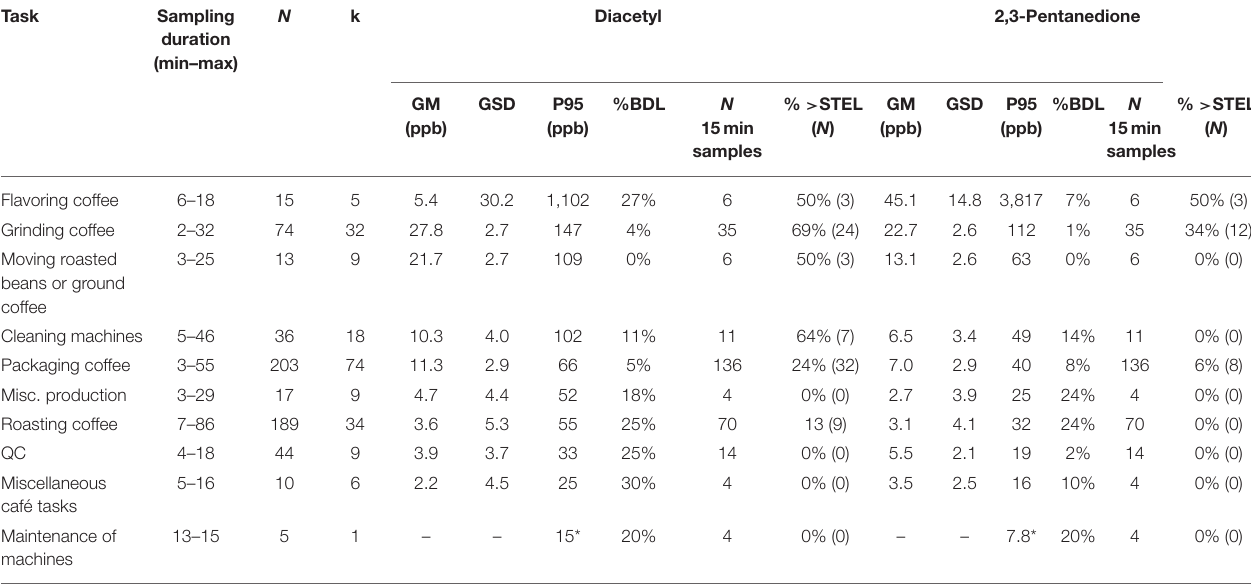
TABLE 1 | Personal short-duration task exposures to diacetyl and 2,3-pentanedione.